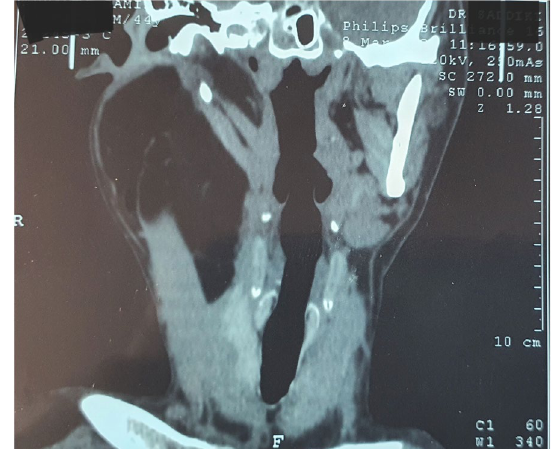
Fig. 3 Coronal CT section showing the nature of the mass (lipoma), its location, and its extension